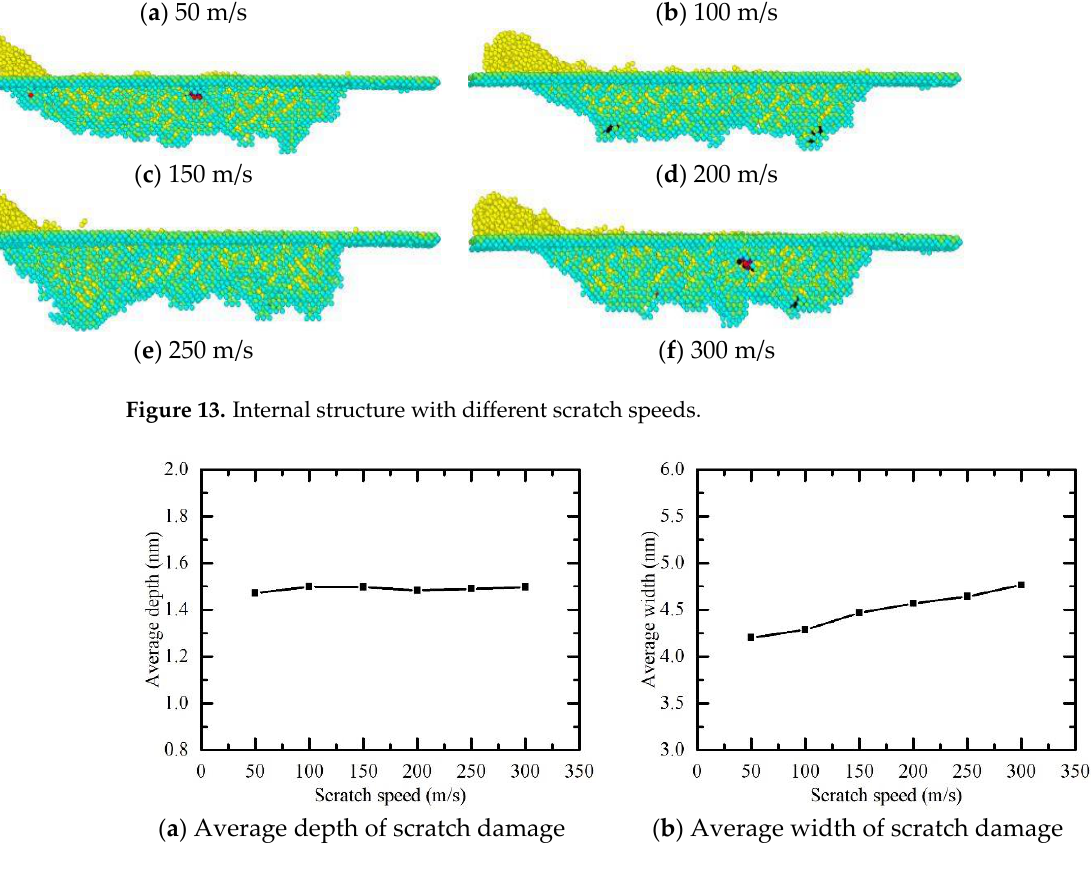
Figure 14. Variation curve for average scratch damage depth and width.